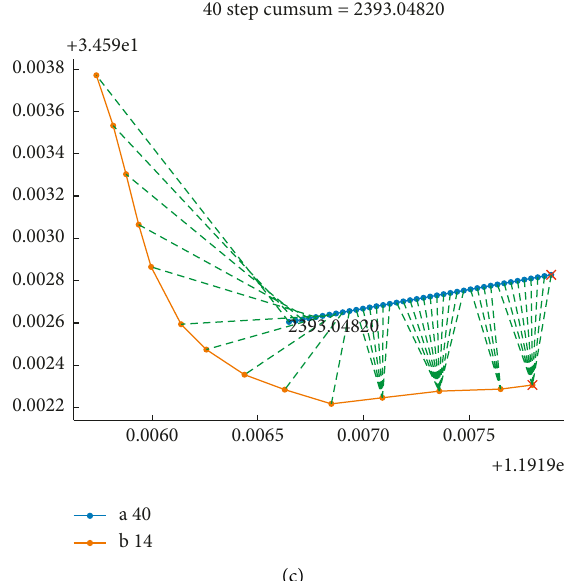
Figure 9: Spatial distribution and matched pairs diagram of DTW between two series a and b . (a) Original samplings for trajectory a , (b) 2 samplings for trajectory a , and (c) 40 samplings for trajectory a